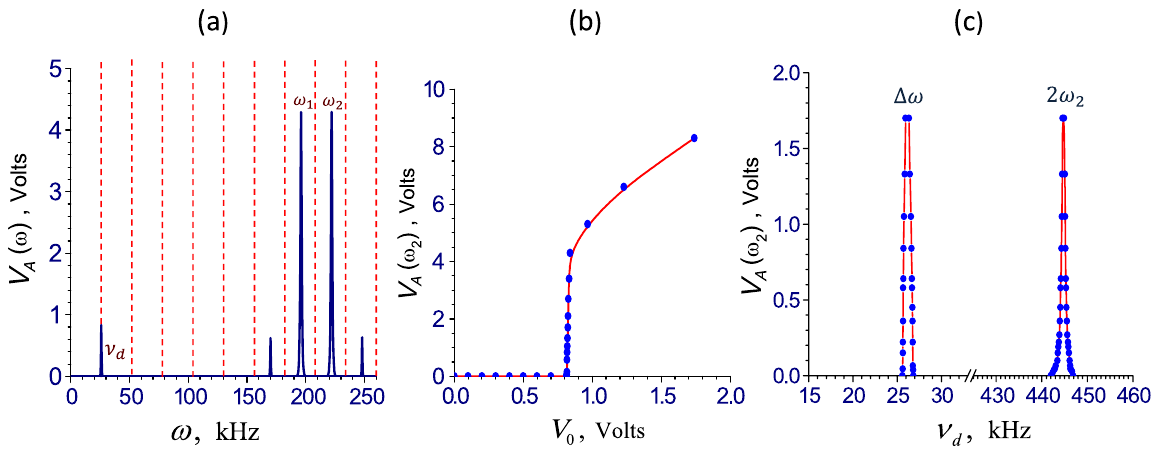
¼ 26 kH z and driving amplitude V ¼ 0 : 9 V 0 d , m ¼ 1 ; 2 ; . . . , indicate the position of higher harmonics of the driving frequency. d ¼ 26 kH z . (c) Dependence d for V 0 ¼ 0 : 825 V . In all plots, the voltage is d